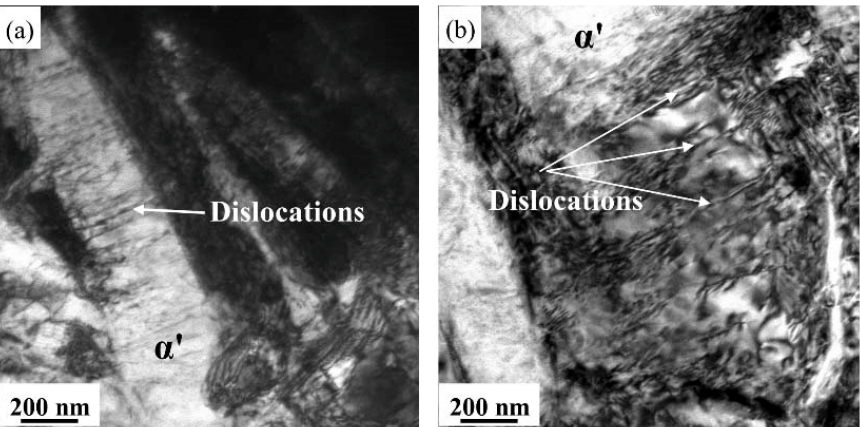
Figure 10. ( a , b ) TEM bright field micrographs of the LPBF-Ti64 sample: α′ martensite and internal.